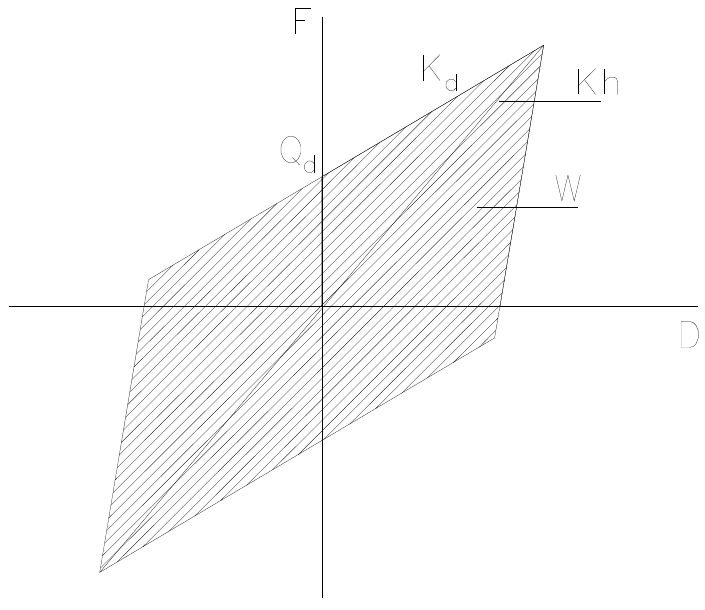
Figure 2. Meanings of K d , Q d , K h and W in the hysteresis loop of bearing. W Figure 2. Meanings of and in the hysteresis loop of bearing. All of the tests were done in the Earthquake Engineering Research and Test Center at Guangzhou University. Figure 3 shows the test equipment and specimen used for K Q K W Figure 2. Meanings of d , d , h and in the hysteresis loop of bearing.